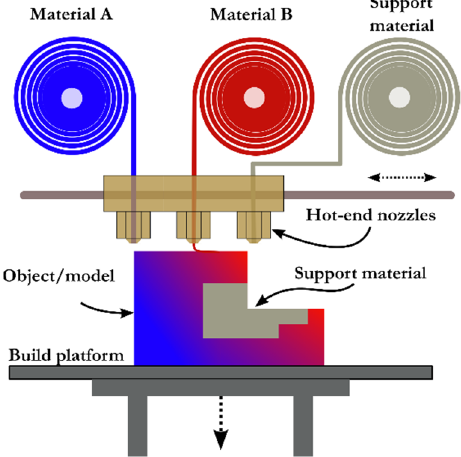
Figure 5. Process description of FFF process.